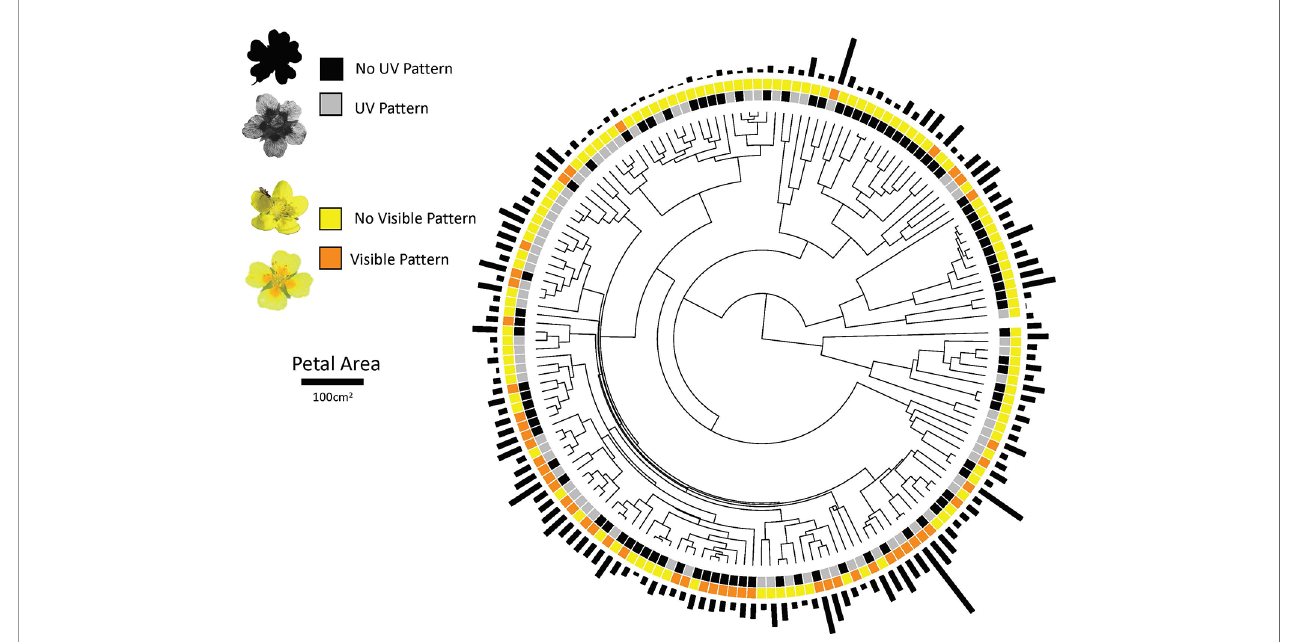
FIGURE 1 | The phylogenetic distribution of ultraviolet and human-visible fl oral pigmentation patterns in and petal area in the Potentilleae tribe. Examples of species that lack UV pattern ( Potentilla evestita ), have UV pattern ( P. eriocarpa ), lack visible pattern ( Argentina anserina ), and have visible pattern ( P. erecta ) are provided in the